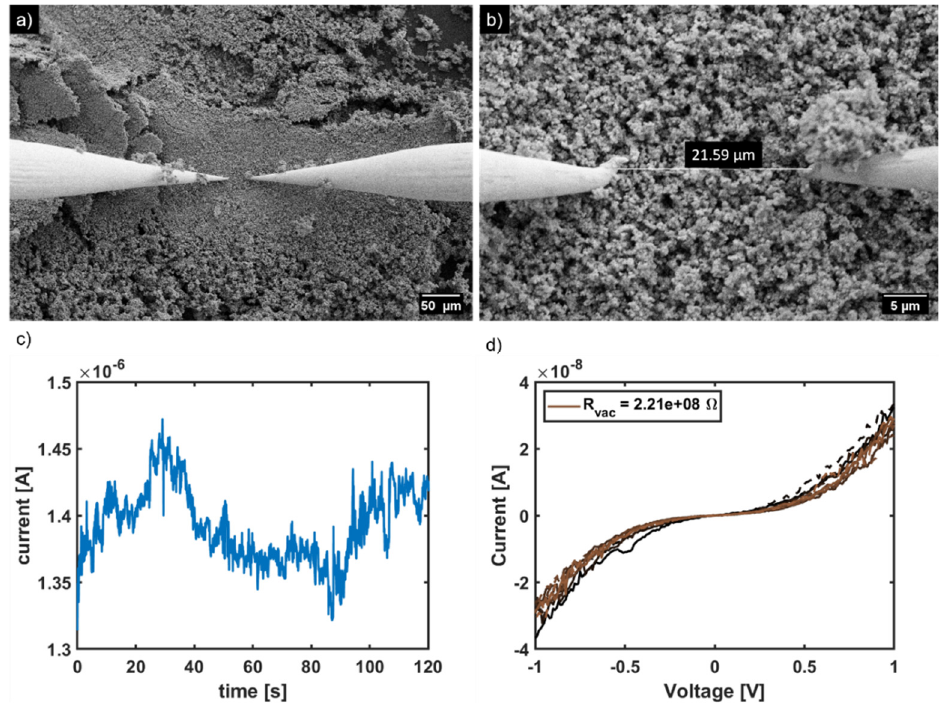
Figure 4. ( a , b ) SEM images during measurement of current between two nanoscale electrodes. ( c ) Measured current with time. ( d ) Calculated resistance in the near low voltage regime.